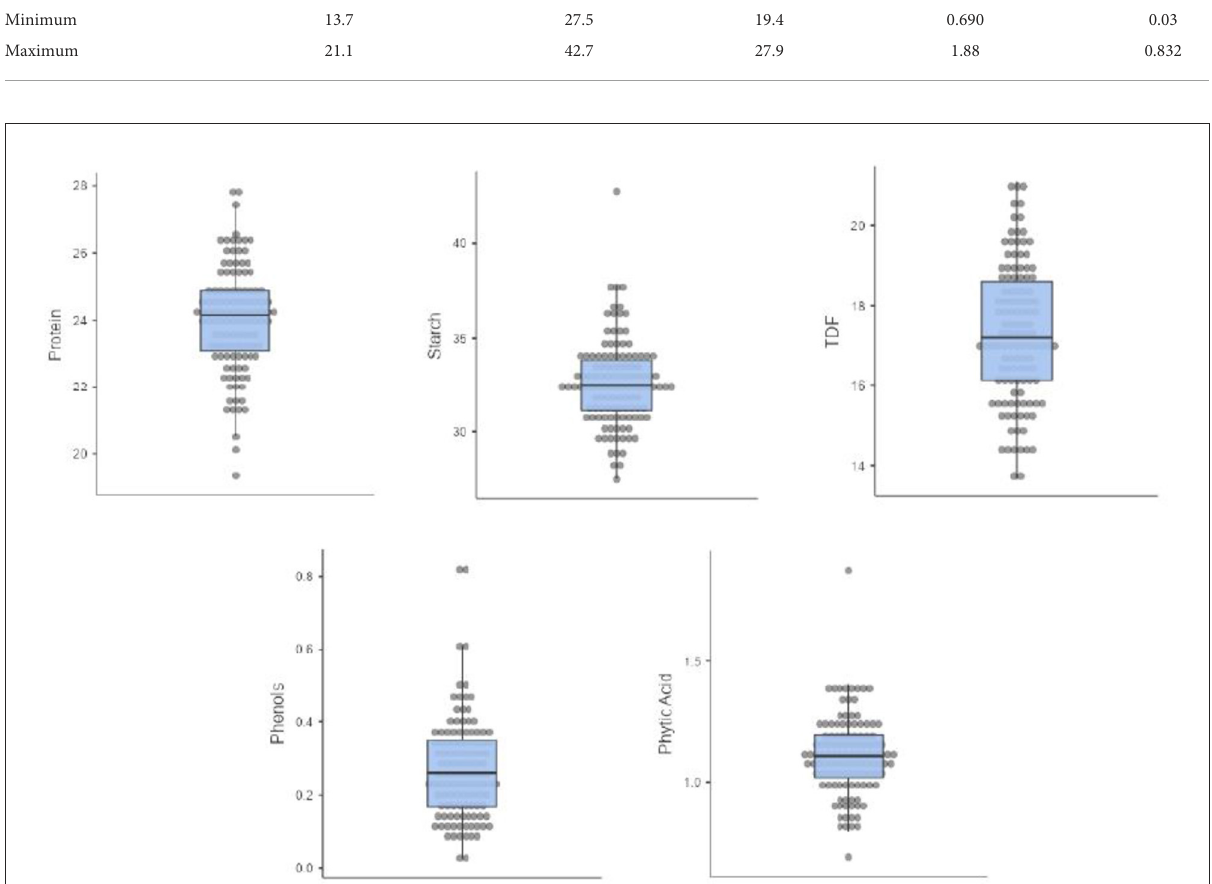
FIGURE1 Box and whisker plots of 121 cowpea germplasm showing the distribution of protein, starch, TDF, phenols, and phytic acid.